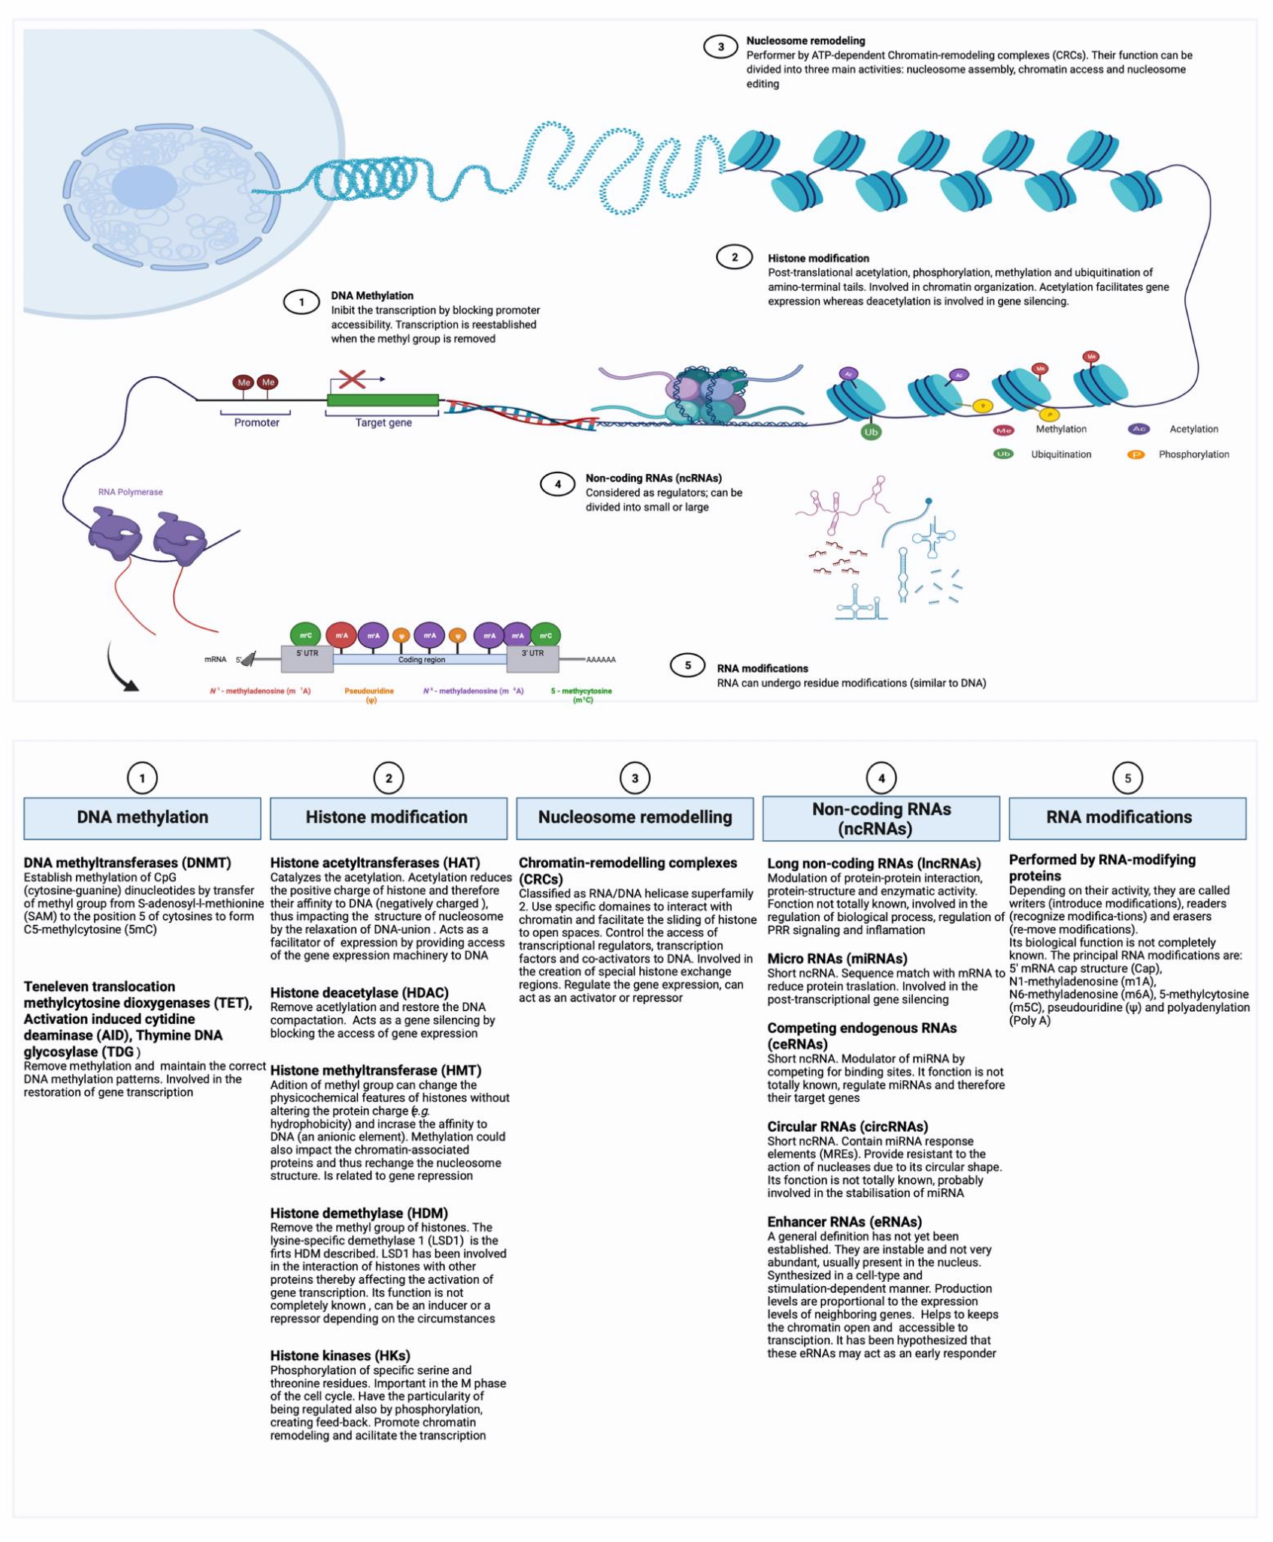
Figure 1. Epigenetic mechanisms involved in trained immunity. Adapted from “Cancer Epigenetics, Icon Pack–Epigenetics, Epigenetics and Gene Expression and Regulation of Transcription in Eukaryotic Cells” templates (Biorender). Retrieved from https://app.biorender.com/biorender-templates, accessed on 23 September 2021). For more information see refs.